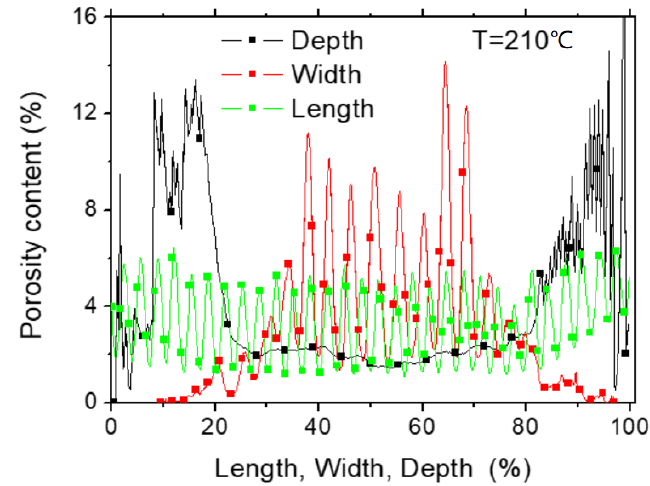
Figure 13. Evolution of the porosity content in the main orthogonal directions of 3D-printed PLA (sample dimensions 17 × 13 × 4 mm 3 (sample dimensions 17 × 13 × 4 mm 3 ).